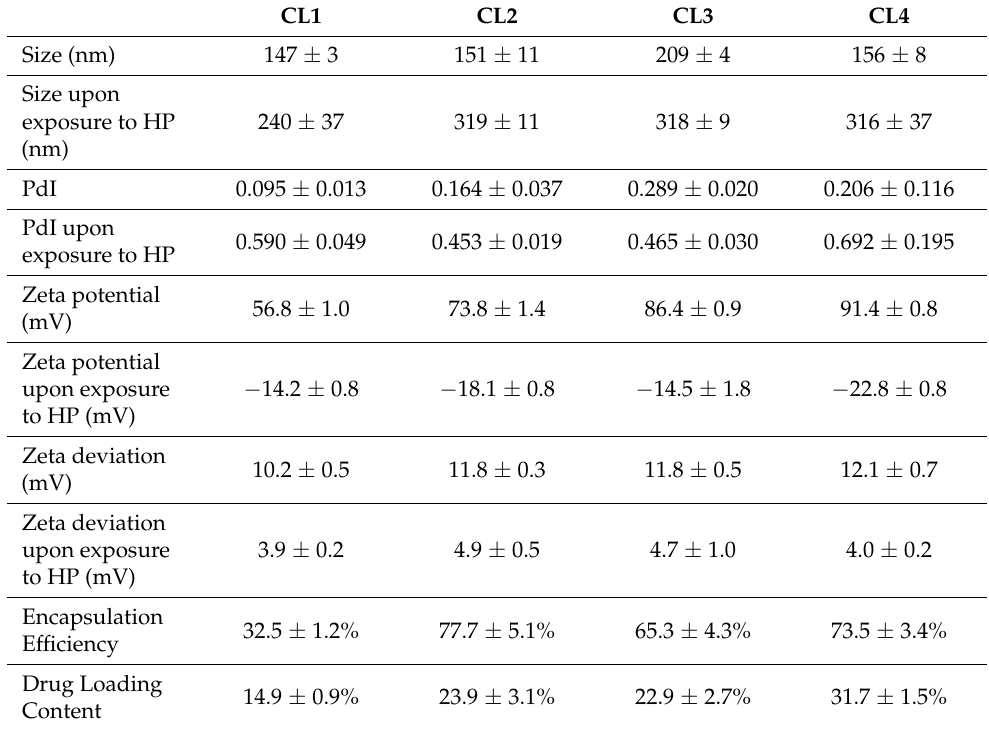
Table 2. Chemical-physical characterization of TMZ-loaded CLs before and after incubation with human plasma (HP). CL1 (DOTAP/cholesterol), CL2 (DOTAP/DOPE), CL3 (DC Chol/DOPE), CL4 (DC-Chol/cholesterol). Zeta deviation is intended as the width distribution as reported by the Malvern Zetasizer software. CL1 CL2 CL3